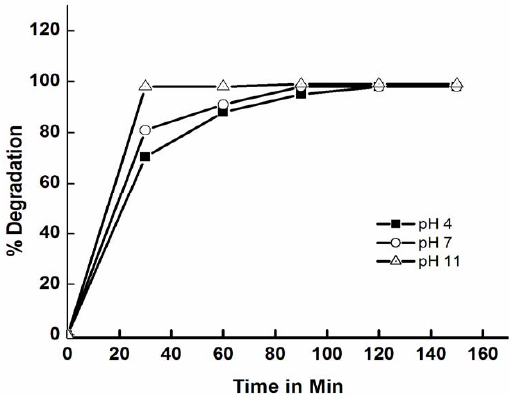
Fig. 9. Caffeine photocatalytic degradation at different pHs